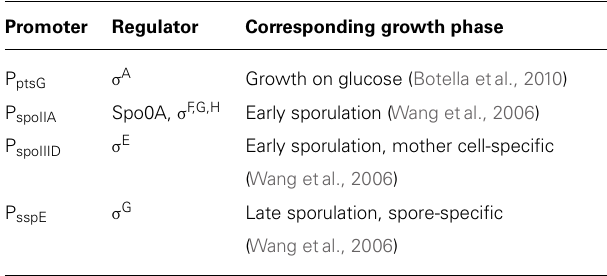
Table 4 | Promoters used for IpHluorin